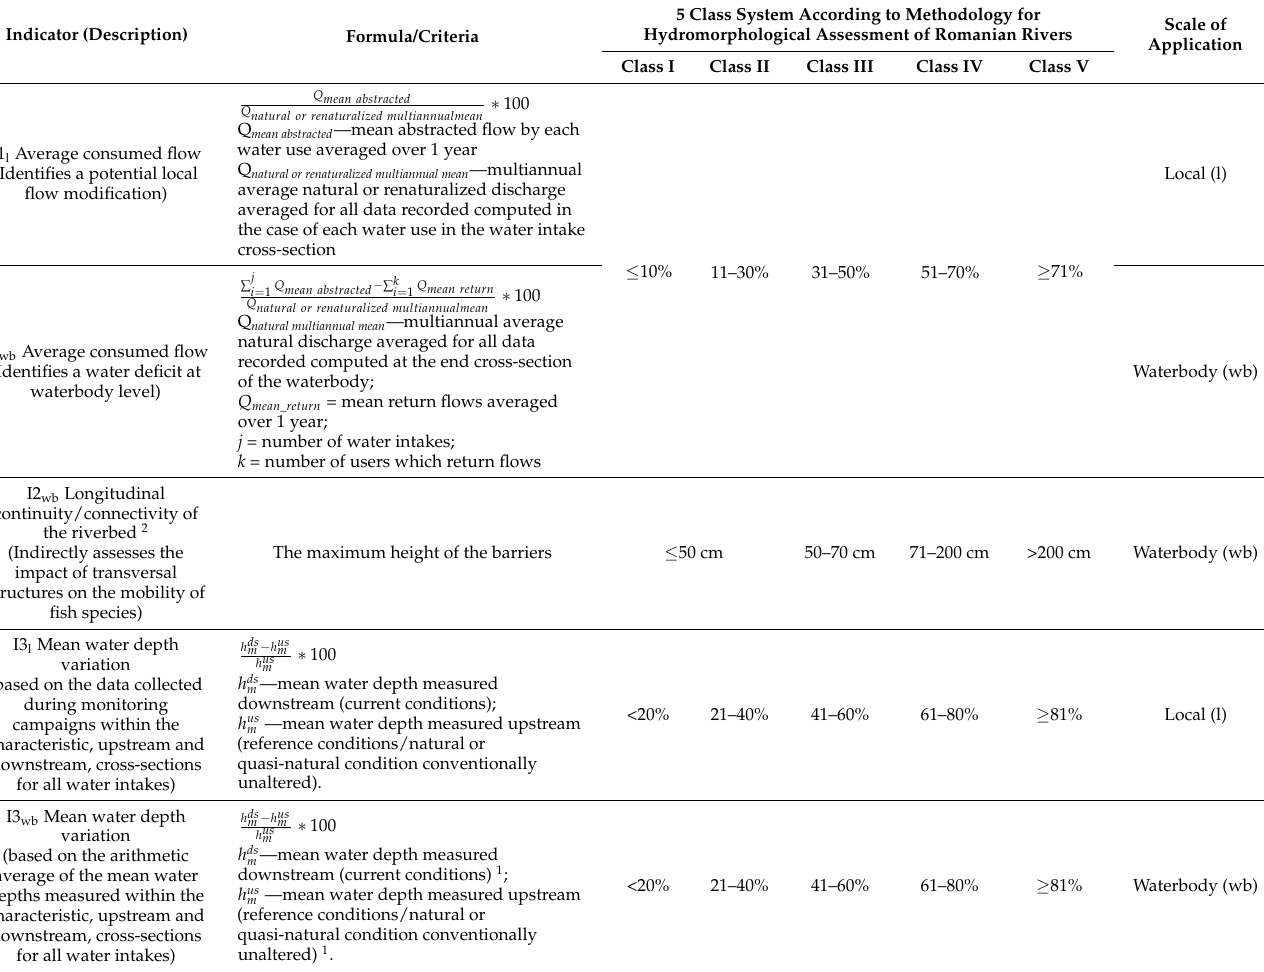
Table 2. The hydromorphological indicators used for the status assessment and cumulative hydro- morphological impact